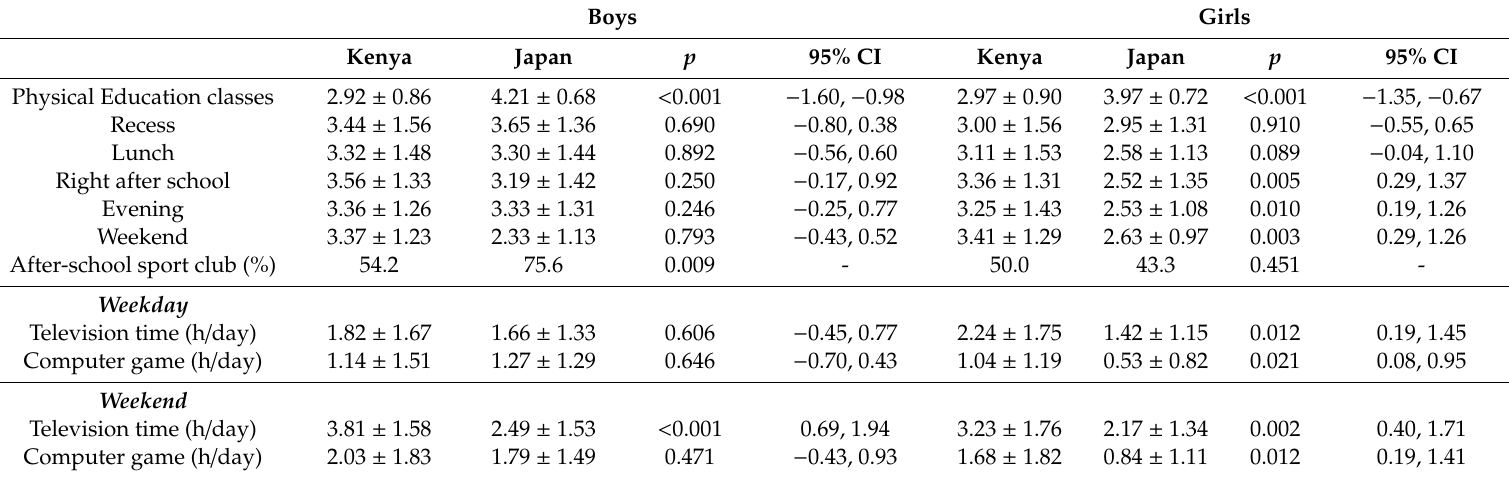
Table 2. Domain-specific physical activity and screen time among Kenyan and Japanese